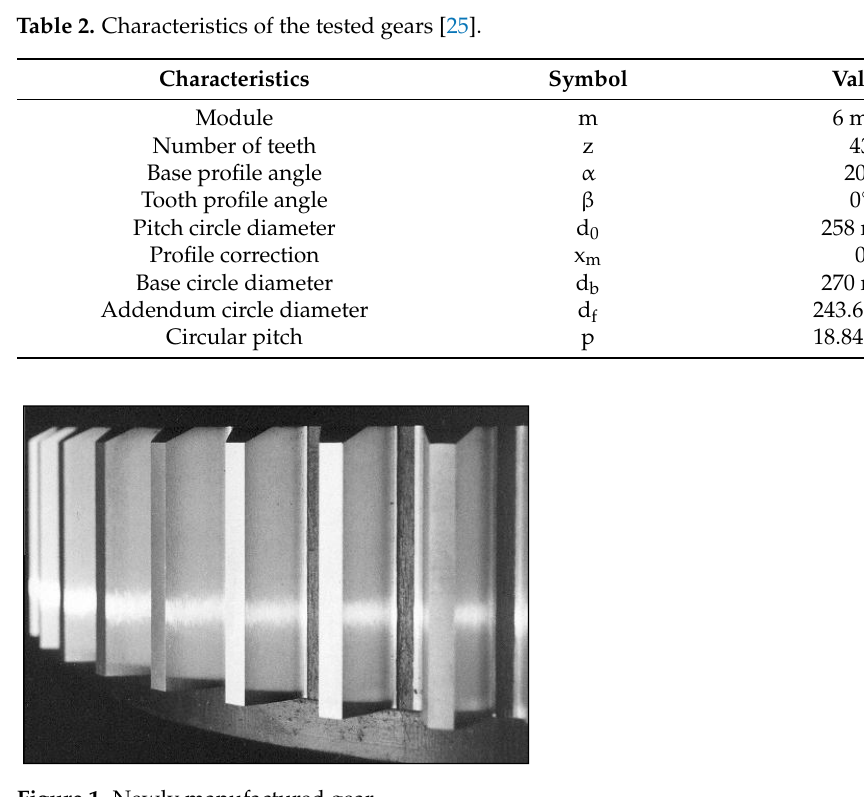
Figure 1. Newly manufactured